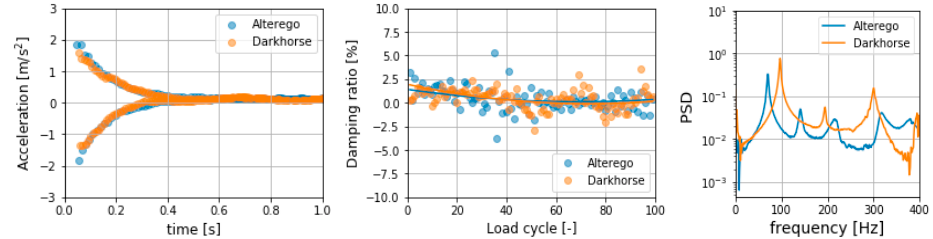
Figure 9. Comparative results from free decay test. ( left ) comparison of decay tests; ( center ) Damping ratio in each cycle; ( right ) PSD Power Spectral Density and natural